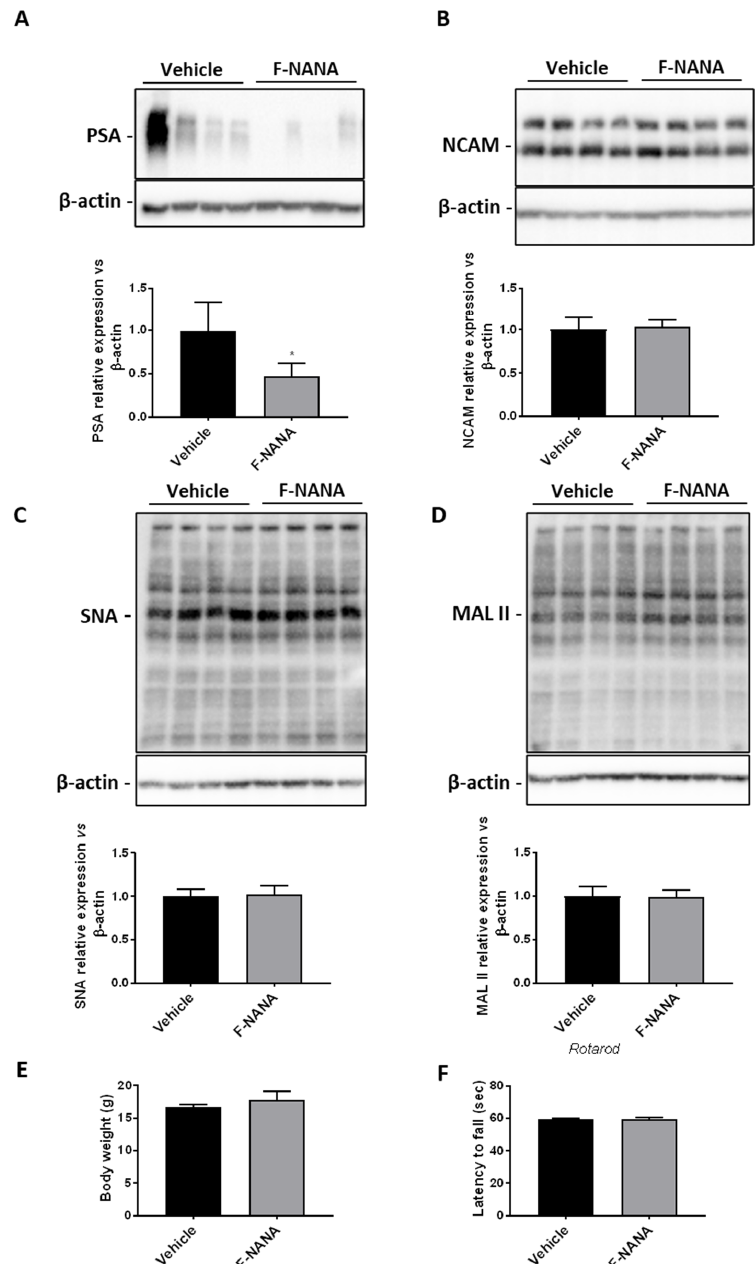
Figure 8. F-NANA reduces the levels of PSA in brain tissues from wild-type mice. Representative cropped Western blottings and densitometric analysis of PSA ( A ) and NCAM ( B ) levels in brain tissues from vehicle- and F-NANA-treated wild-type mice at 7 weeks of age. Data are represented as mean ± SD, N = 5 for each group of mice. *, p < 0.05; (Unpaired t -test). Representative cropped Western blottings and densitometric analysis of SNA ( C ) and MAL II ( D ) levels in brain tissues from the vehicle- and F-NANA-treated wild-type mice at 7 weeks of age. Data are represented as mean ± SD, N = 5 for each group of mice. ( E ) Mouse body weight measured at the end of the treatment. Values are represented as mean ± SD. ( N = 5 for each group of mice). (Unpaired t -test). ( F ) Motor performance assessed by Rotarod test. Values are represented as mean ± SD. ( N = 5 for each group of mice). (Unpaired t